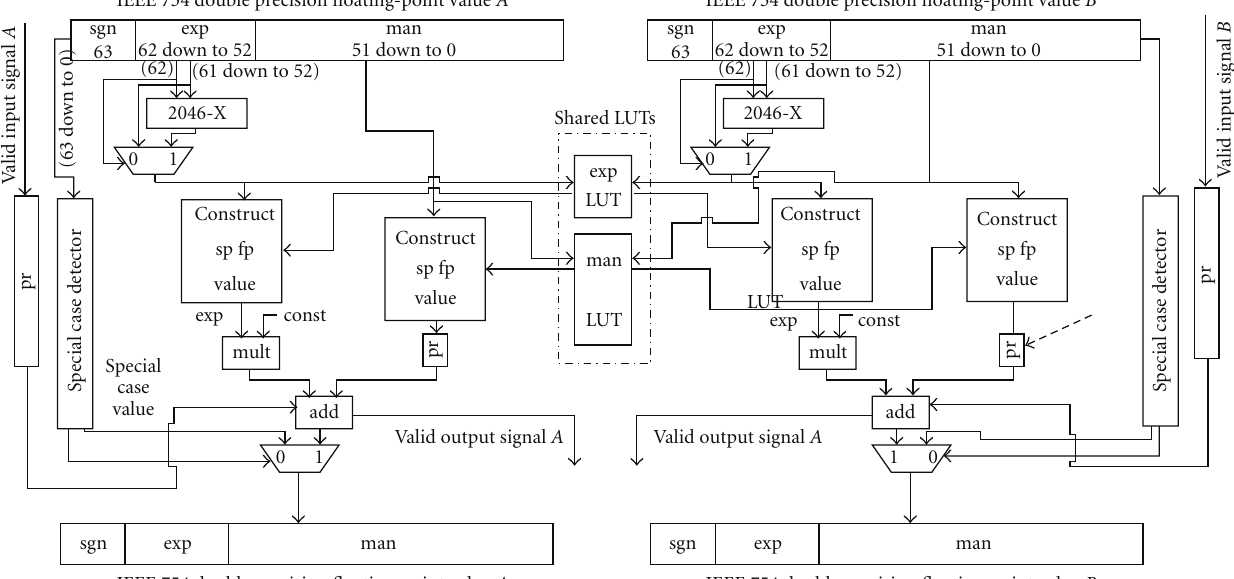
Figure 4: Top-level design of the VLAU architecture.